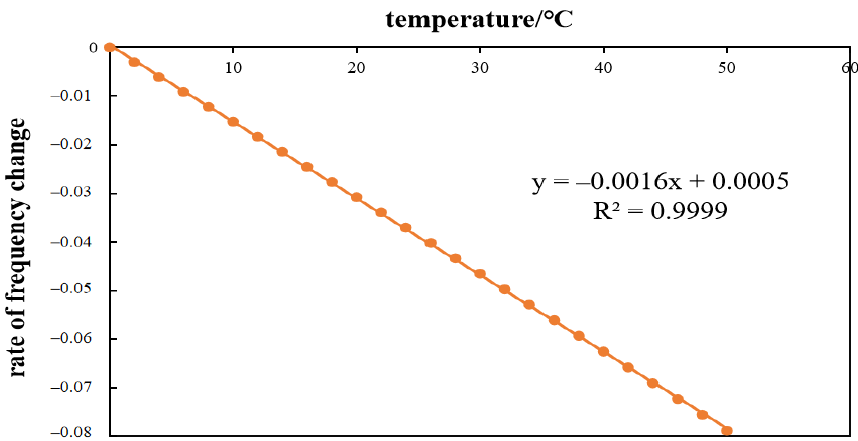
Figure 2. The relationship between ∆𝑓 𝑛 and ∆𝑇 .